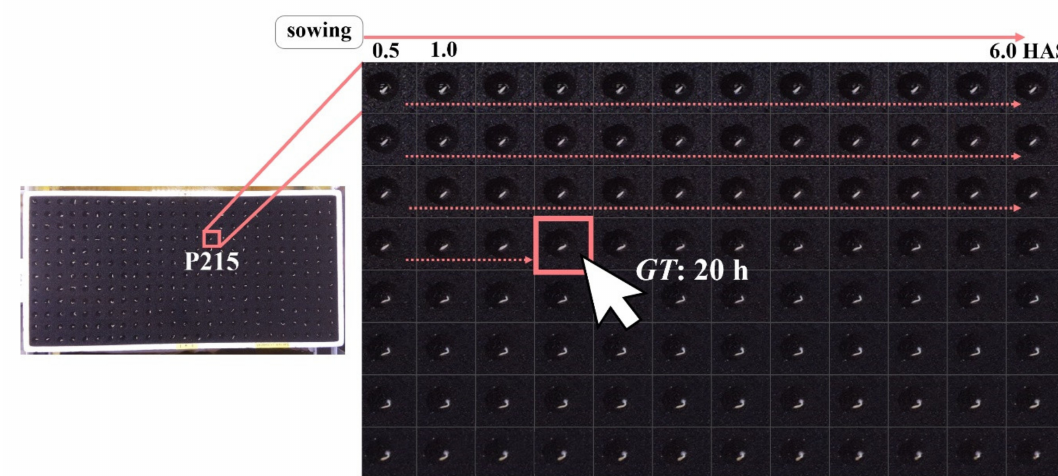
Figure 3. Process of acquiring germination time ( GT ) from time series red-green-blue (RGB) image data. Time series RGB images of seed trays were obtained from the RGB camera at set intervals and then sent automatically to the data warehouse (DWH) (left image). Each RGB image covers one seed tray with 300 seeds on a foamed urethan substrate (left image). An example of marked seed number P215 is shown (left image). After each RGB image of seed tray is segmented into 300 images of individual seeds, time series of individual seed images are re-sequenced in a chronological order to determine GT by selecting the germinated seed (right image). Time course RGB data of seed P215 every 0.5 h (HAS: hours after sowing) with GT of 20 h is shown (right